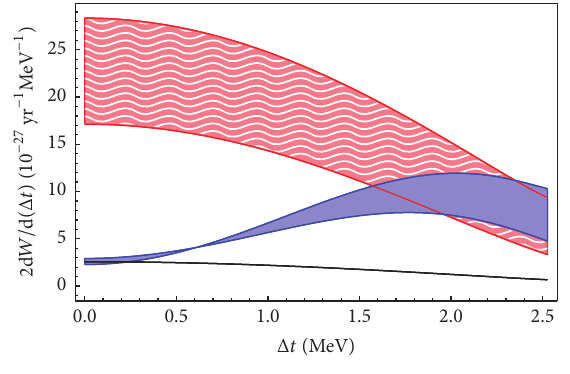
Figure 6: Same as Figure 5 for 130